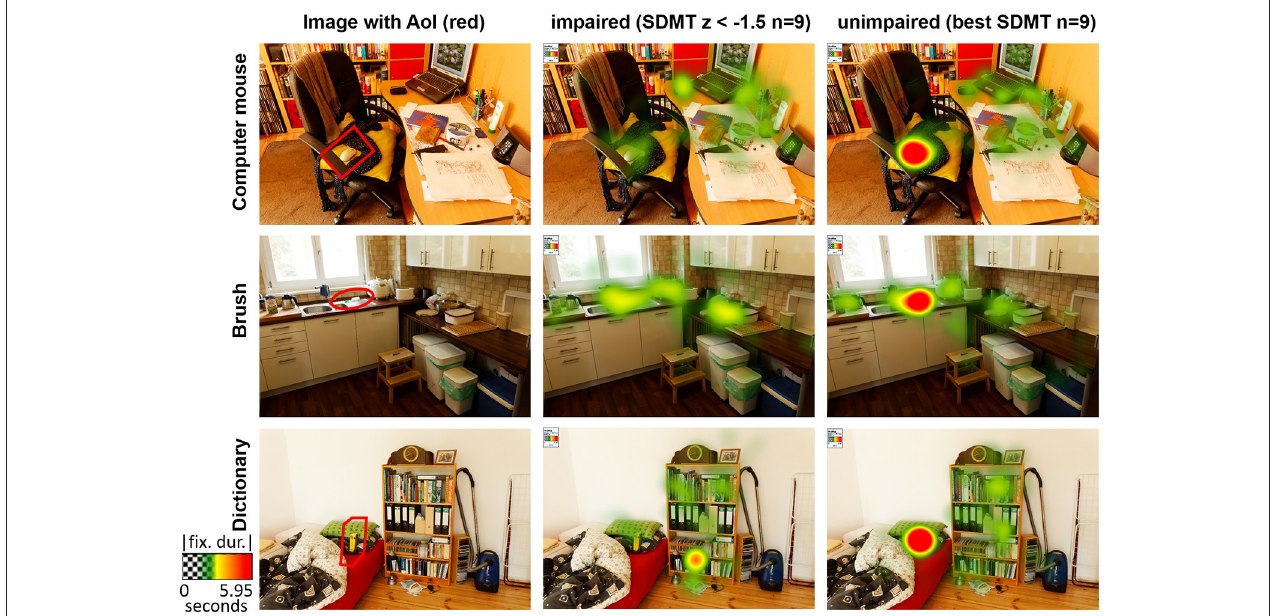
FIGURE 1 | Example pictures of the BOiS-Database (16) showing everyday scenarios. In the left column the area of interest (AoI), which corresponds to the shape of the target object, is marked in red. The heatmap color codes the absolute fixation duration. Heatmaps are shown for the cognitively impaired patients (SDMT z < –1.5 ( n = 9), mean SDMT z : − 2.28 ± 0.48) and for illustrating purposes the 9 patients with the highest SDMT (mean SDMT z : 0.59 ± 0.35).